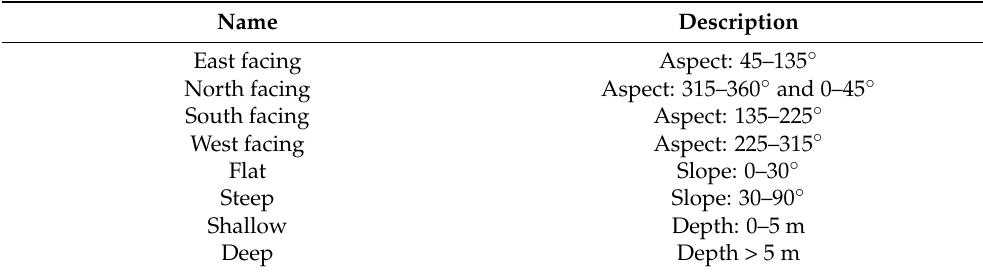
Table 1. Ranges of variables for aspect, slope, and depth to define topographic parameters for the Ningaloo